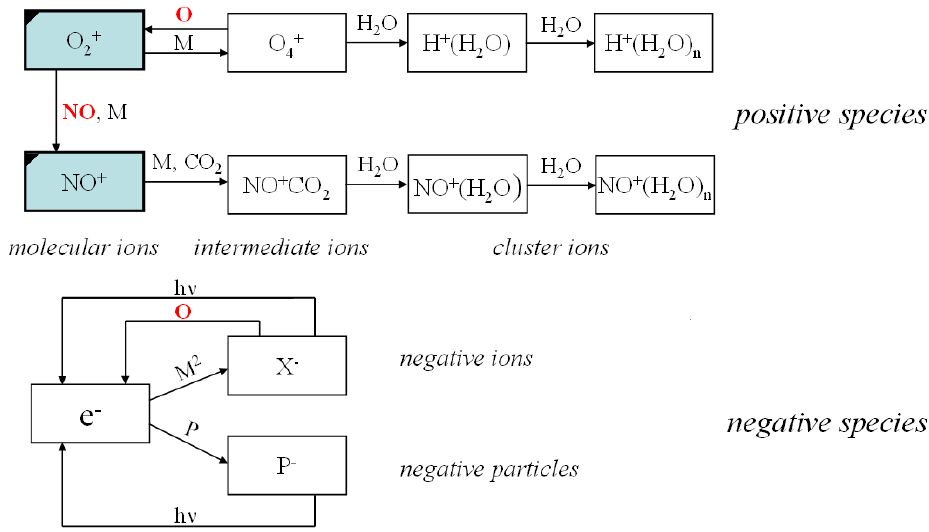
Fig. 1. Simplified ion-chemistry in the mesosphere (D-region). Ions in the shaded boxes are the ones primarily produced. For graphical reasons the reactions between the negative species (e - , X - , and P - ) to all of the positive species are omitted (M = background number density, NO = nitric oxide, O = atomic oxygen, P = particle).